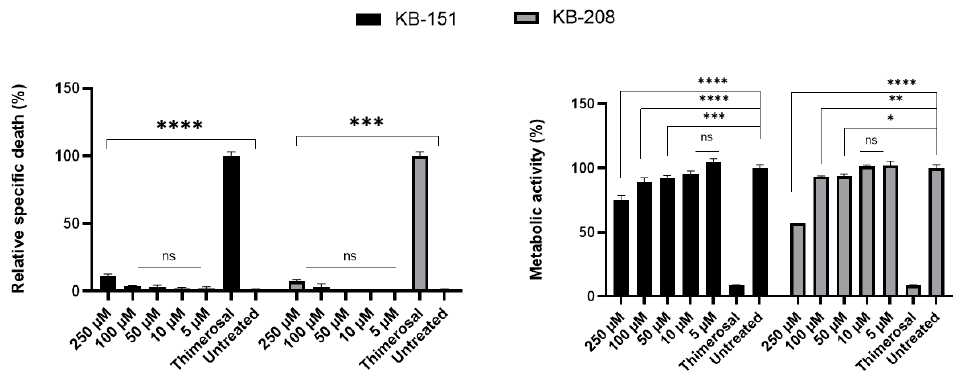
Figure 7. Toxicity assay after 24 h incubation of PBMCs with KB-151 and KB-208 . MTT ( right ) and LDH ( left ) results for PBMC using high concentration (up to 250 µM) of KB-151 (black) and KB-208 (grey). Y -axis for MTT graph shows the percentage of metabolic activity which is related to the cell viability and for LDH graph, shows the percentage of relative specific death which related to the cell toxicity. X -axis of both MTT and LDH show different concentrations of KB-151 and KB-208 , Thimerosal at 100 µM as control toxicity (* p < 0.05, ** p < 0.01, *** p < 0.001 and **** p < 0.0001), and untreated control. Bars represent mean ± SD, and N = 3.